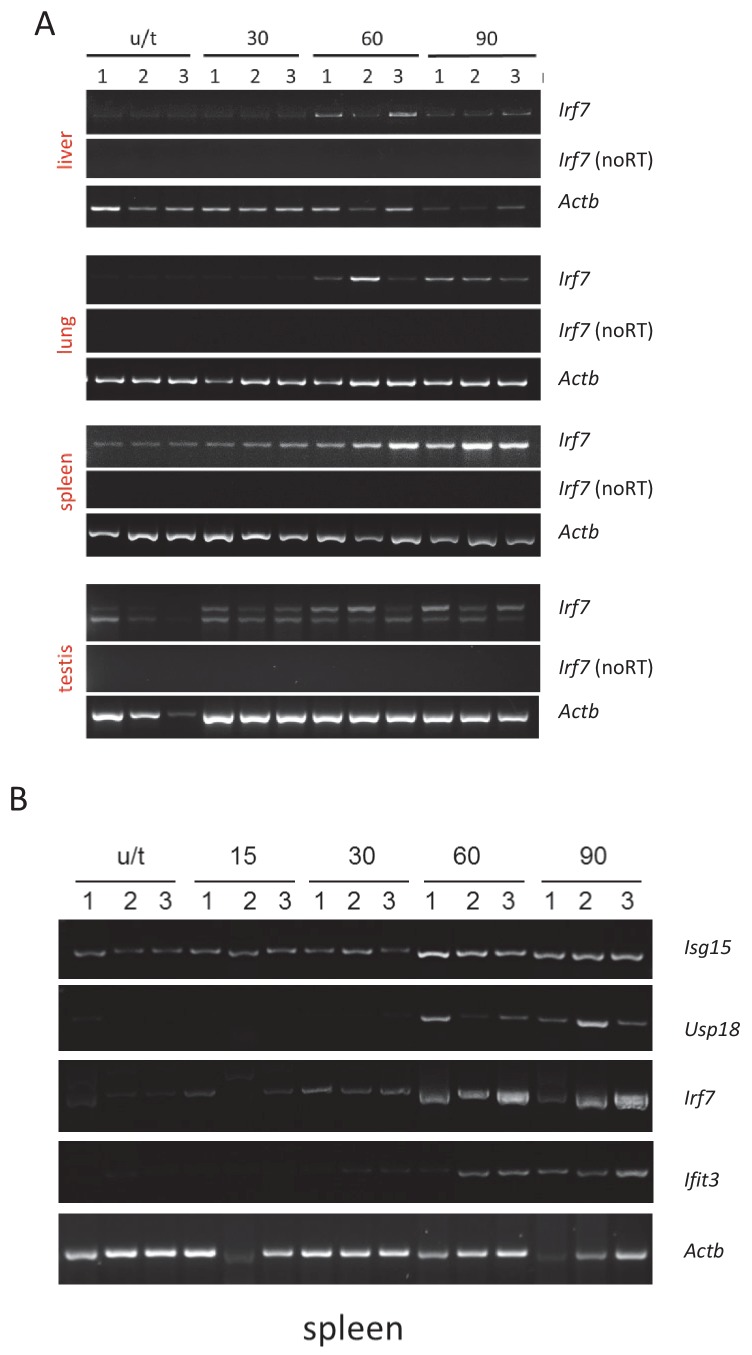
Images of RT-PCR reactions used for quantitation on Figure 3.